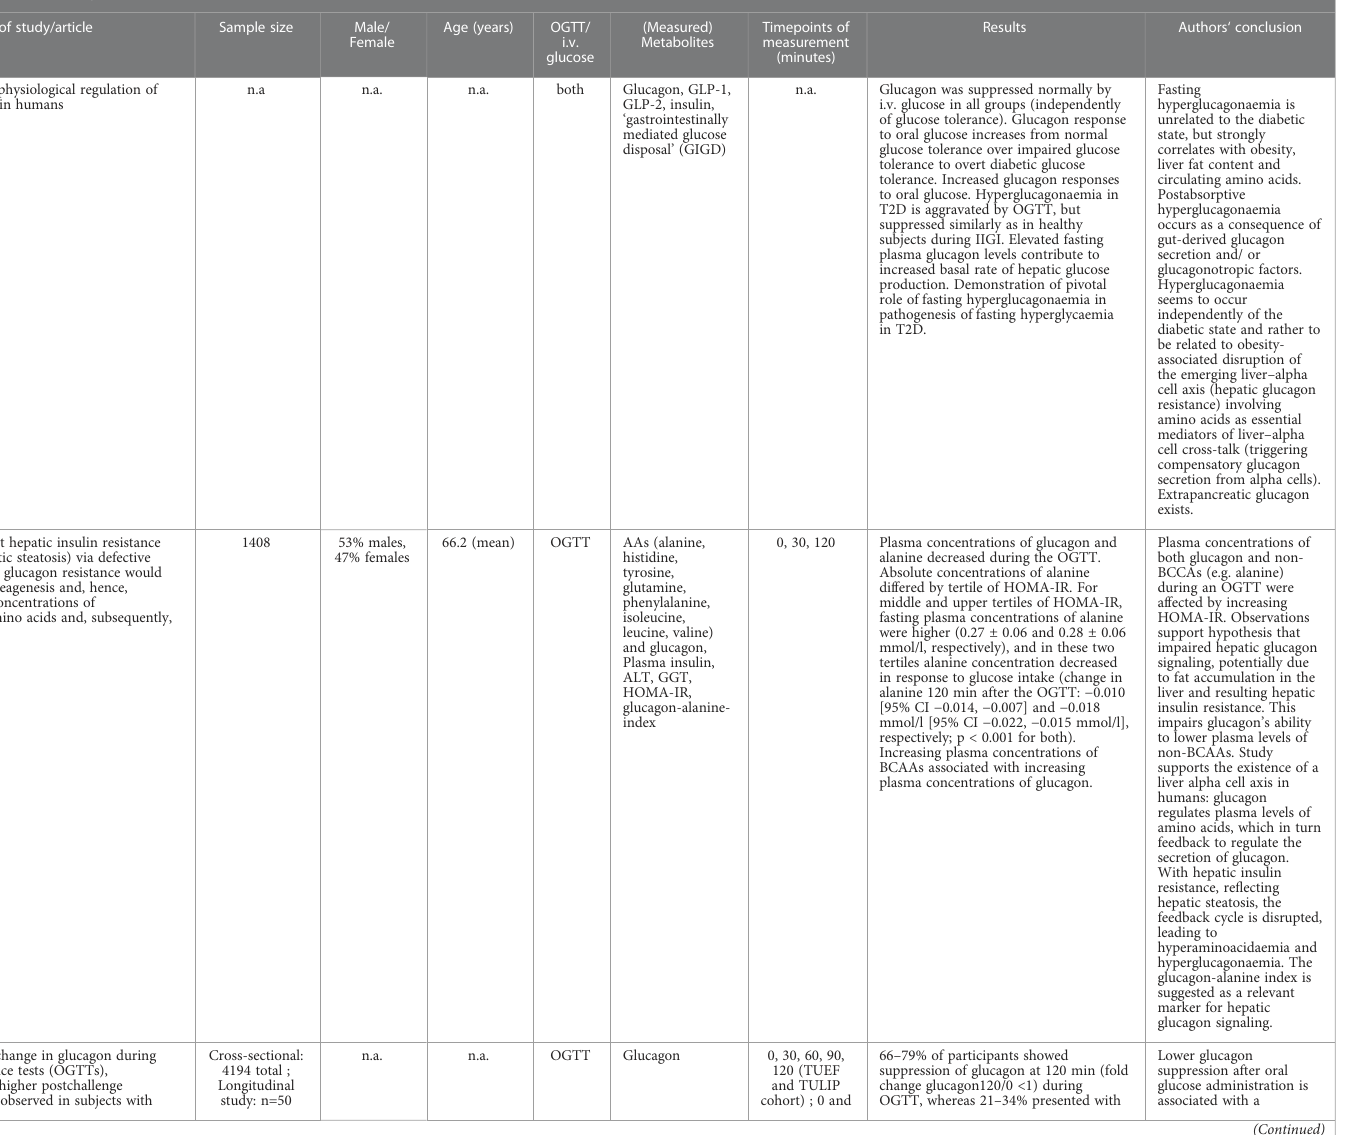
TABLE 1 Studies on the dynamics of glucagon after administration of glucose. Studies on the dynamics of glucagon after administration of glucose